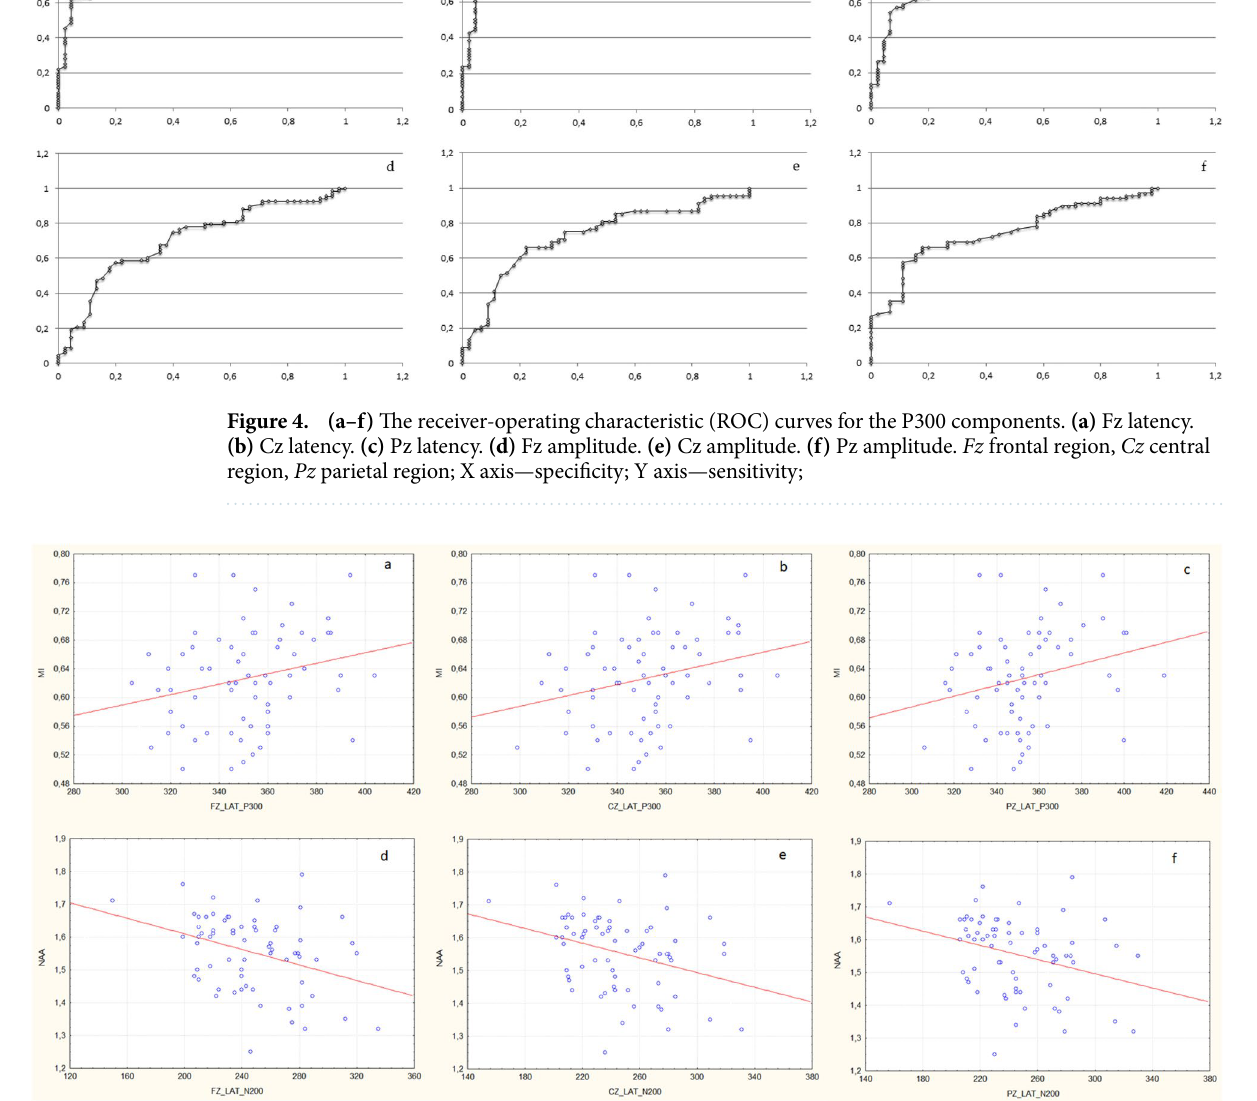
Correlations of EPR and thyroid hormones. There were no statistically significant correlations between the mean ERP parameters, thyroid hormones levels, and TGAb and TPOAb either. Correlations of MRS measurements and thyroid hormones. The MRS parameters showed no statis- tically significant correlations neither with thyroid hormones levels nor TGAb and TPOAb .